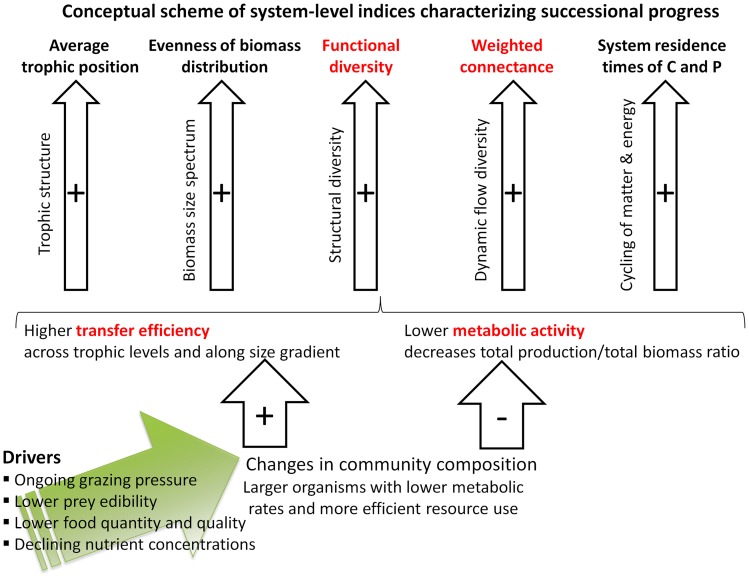
Conceptual scheme linking indices of successional progress.Several drivers of successional progress induce changes in community composition during succession in LC. Higher average body size entails lower system metabolic activity and respiration, while the feeding activities of the more diverse and more specialized consumer community combined with lower non-grazing mortality result in a more efficient exploitation of food resources. These changes in size, diet, and trophic structure enhance the efficiency of the energy transfer towards higher trophic levels and along the size gradient. With more energy reaching larger consumers and the higher trophic levels, biomass becomes more evenly distributed along the size gradient in a functionally more diverse and more complex food web with more closed energy and nutrient cycles. Four key indices (i.e. the transfer efficiency across trophic levels TE, the system metabolic activity Ptot/Btot, the functional diversity Hbio, and the weighted connectance Cw) are marked in red and combined to a composite index of successional progress (Fig. 9).